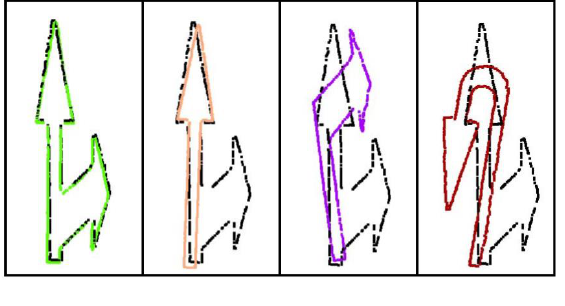
Figure 5. An example of the classification by model matching based on